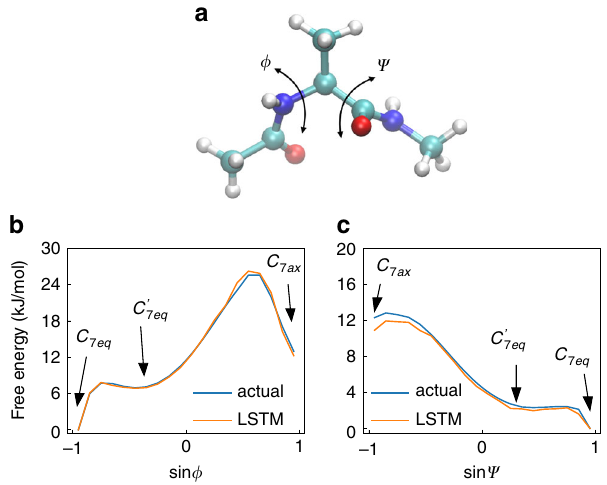
Fig. 5 Boltzmann statistics for alanine dipeptide. a The molecular structure of alanine dipeptide used in the actual MD simulation. The torsional angles ϕ and ψ as the collective variables (CVs) are shown. b and c The 1-dimensional free energy curves along sin ϕ and sin ψ are calculated using actual MD data and the data generated from LSTM. For the calculation of a different epoch, please see Supplementary Note 2 and Supplementary Table 1.